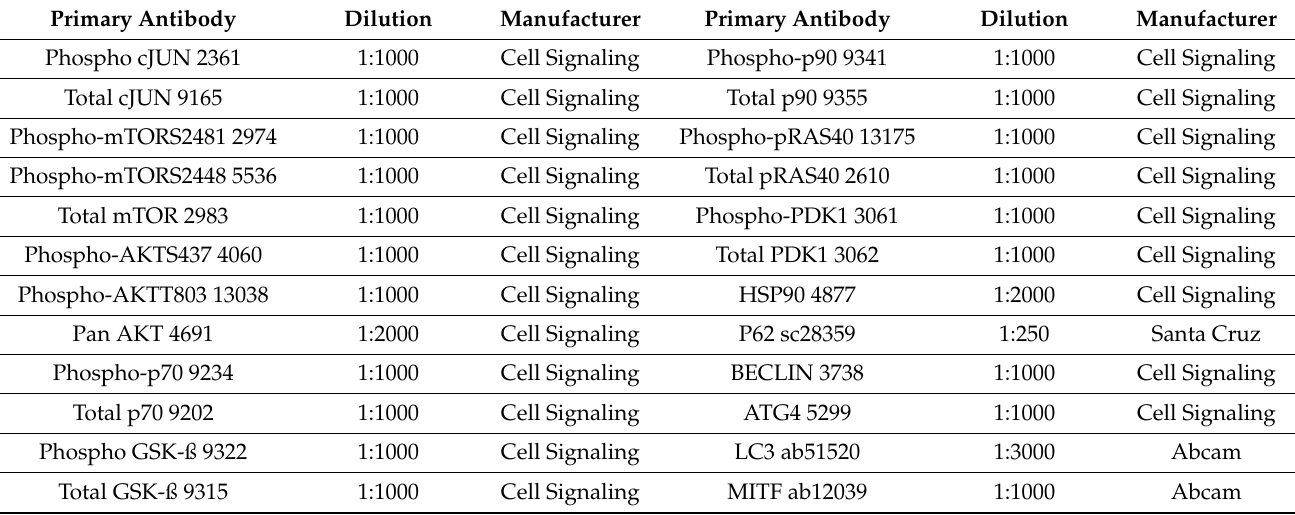
Table 1. List of primary